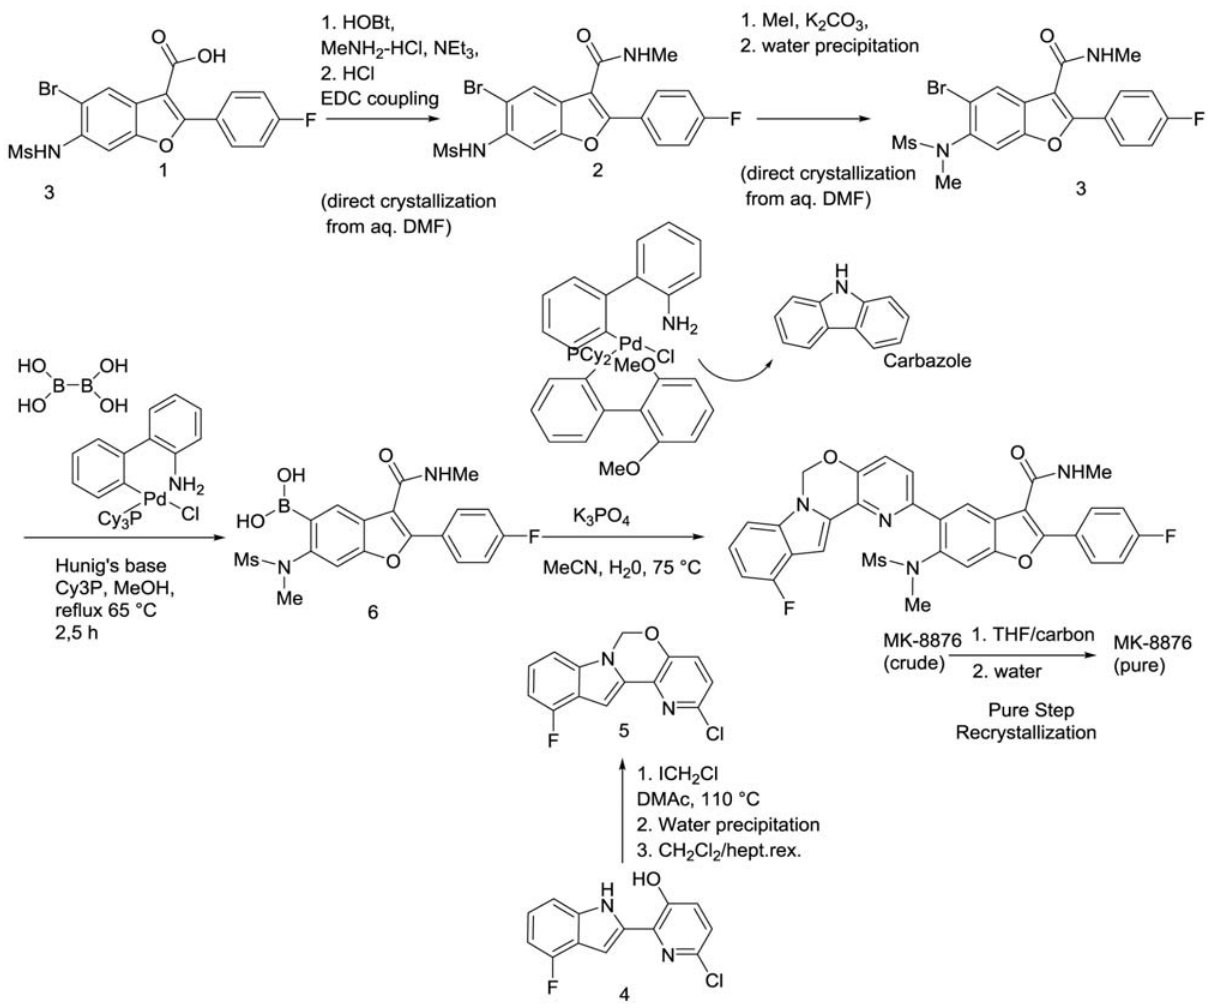
Scheme 3 : Synthesis of MK-8876 (adapted from McLaughlin et al. 33